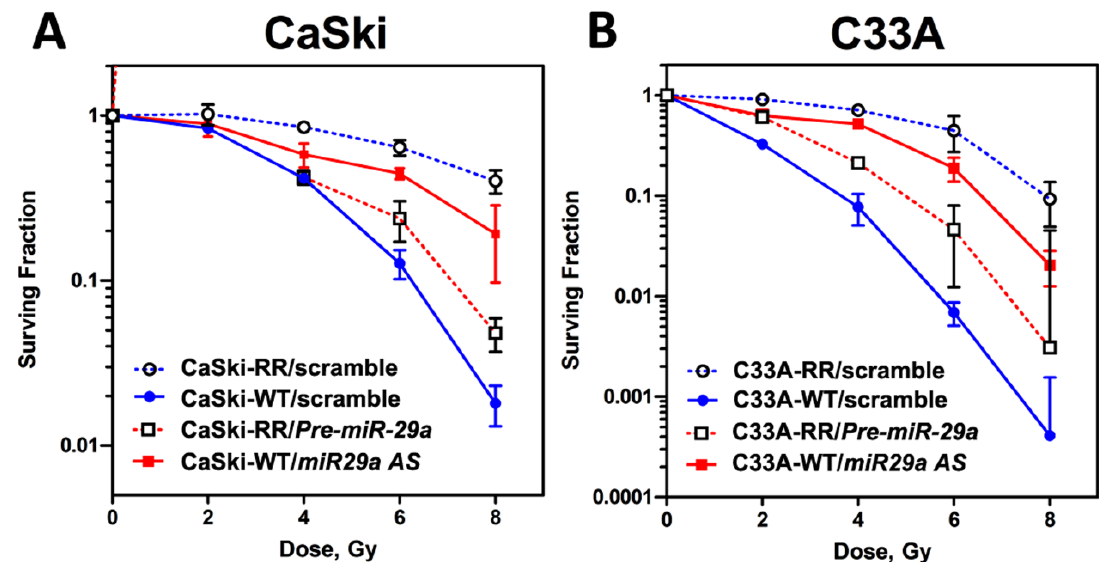
Figure 2. Radiation survival curve of CaSki and C33A cells performed on cells in log phase growth to evaluate the radiosensitivity. Wild-type (WT) cells were transfected with Scrambled NC (100 nM) or miR-29a antisense (also termed miR-29a AS; 100 nM) , whereas the radioresistant (RR) cells were transfected with Scrambled NC (100 nM) or Pre miR-29a precursor (also termed Pre miR-29a; 100 nM), respectively. Cells were plated, irradiated, and assayed for clonogenic survival at the designated dosages. All of the clonogenic assays were repeated at least three times, as described in Section 4.5. The survival curve showed the reduced radiosensitivity of the stable radioresistant clones of ( A ) CaSki and ( B ) C33A cells to irradiation compared to their parental wild-type cells. RR-cells transfected with Pre miR-29a reduced the surviving fraction (elevated radiosensitivity), while WT-cells transfected with miR-29a AS enhanced the surviving fraction (decreased radiosensitivity). Shown are mean values, and error bars show the standard deviation (SD). Solid and dotted curves represent WT and RR cells, respectively. Filled circles, WT-Scrambled NC; open circles, RR-Scrambled NC. Filled squares, WT- miR-29a AS ; open squares, RR- Pre miR-29a . Each experiment was performed in triplicate and the results were